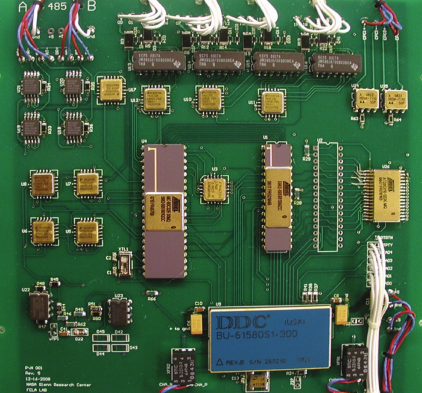
Figure5:PhotographoftheflightCommunicationsInterfaceBoard (CIB) circuit board. This image was taken prior to delivery, during functional testing of the circuit board, and prior to the insertion of the flight MIL-STD-1553 transceiver (image courtesy of